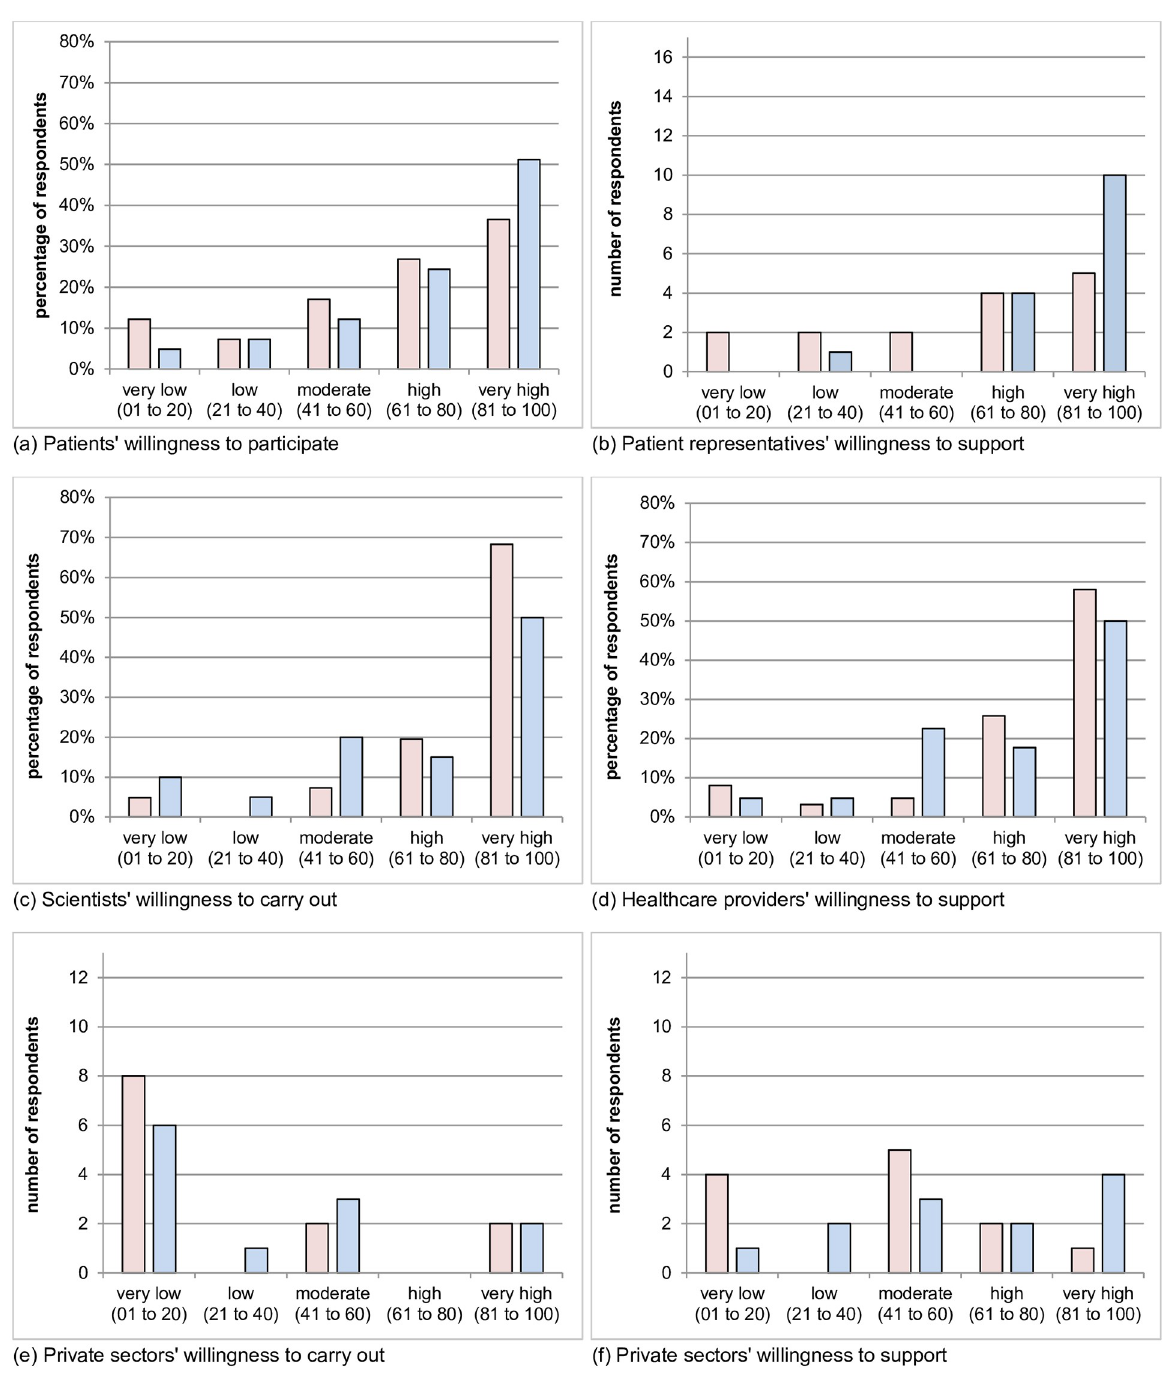
Fig 1. Willingness with regard to study type. Red: randomised controlled trials; blue: observational studies.